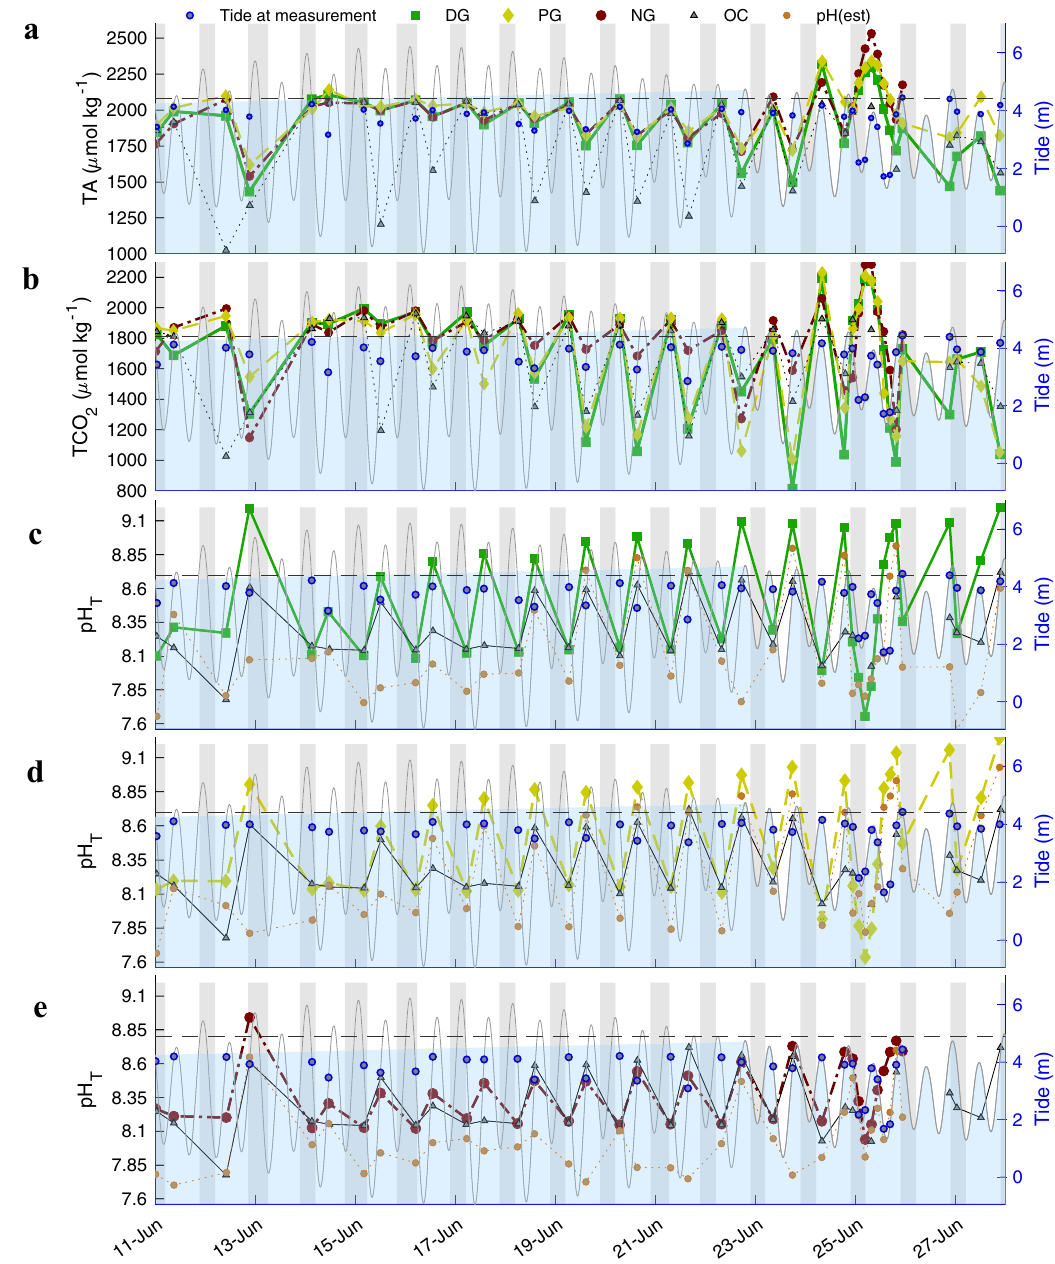
Figure 1. Timeseries of measured TA ( a ), TCO 2 ( b ), pH T and estimated pH T ( c – e ) in dense grass (DG), patchy grass (PG), no grass (NG), and ocean (OC). Shaded blue region is predicted tide and shaded grey is night when PAR < 100 μmol photons m −2 s −1 . Dashed line indicates tidal height when pools become immersed and tidal height at when samples were taken (blue dots). Three-hour sampling occurred for a period of 24 h starting 24 June